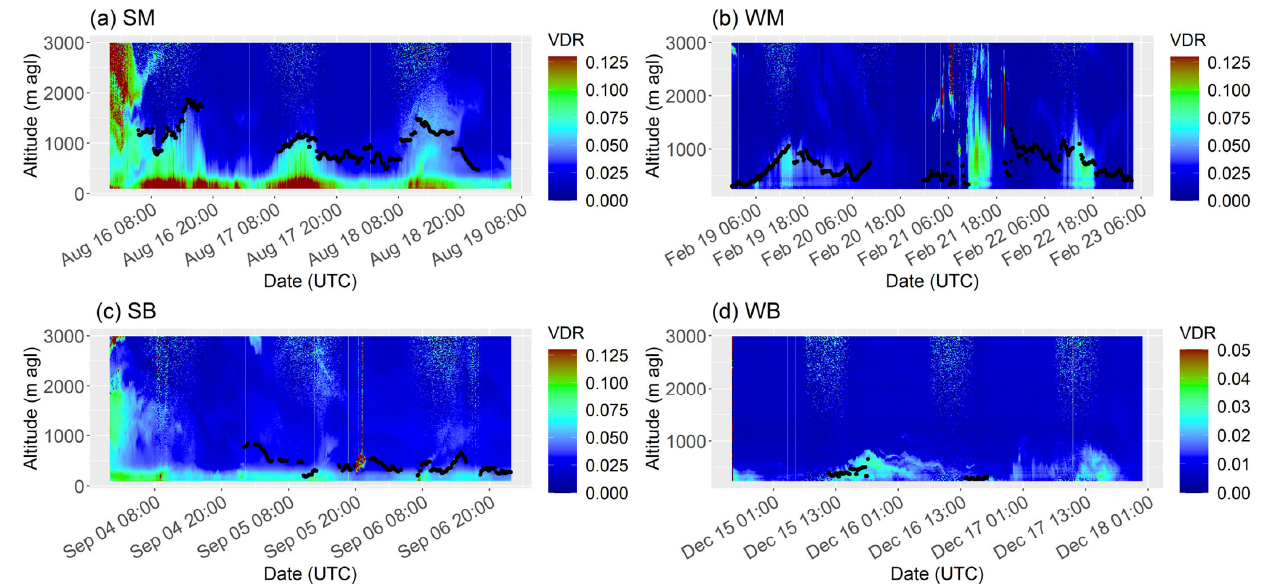
Figure 10. Depolarization Ratio (VDR) during SM event ( a ), WM event ( b ), SB event ( c ), and WB event ( d ); black dots stand for the ABLH calculated and then visually flagged as “good”. Note that the VDR scale is adapted to each case.